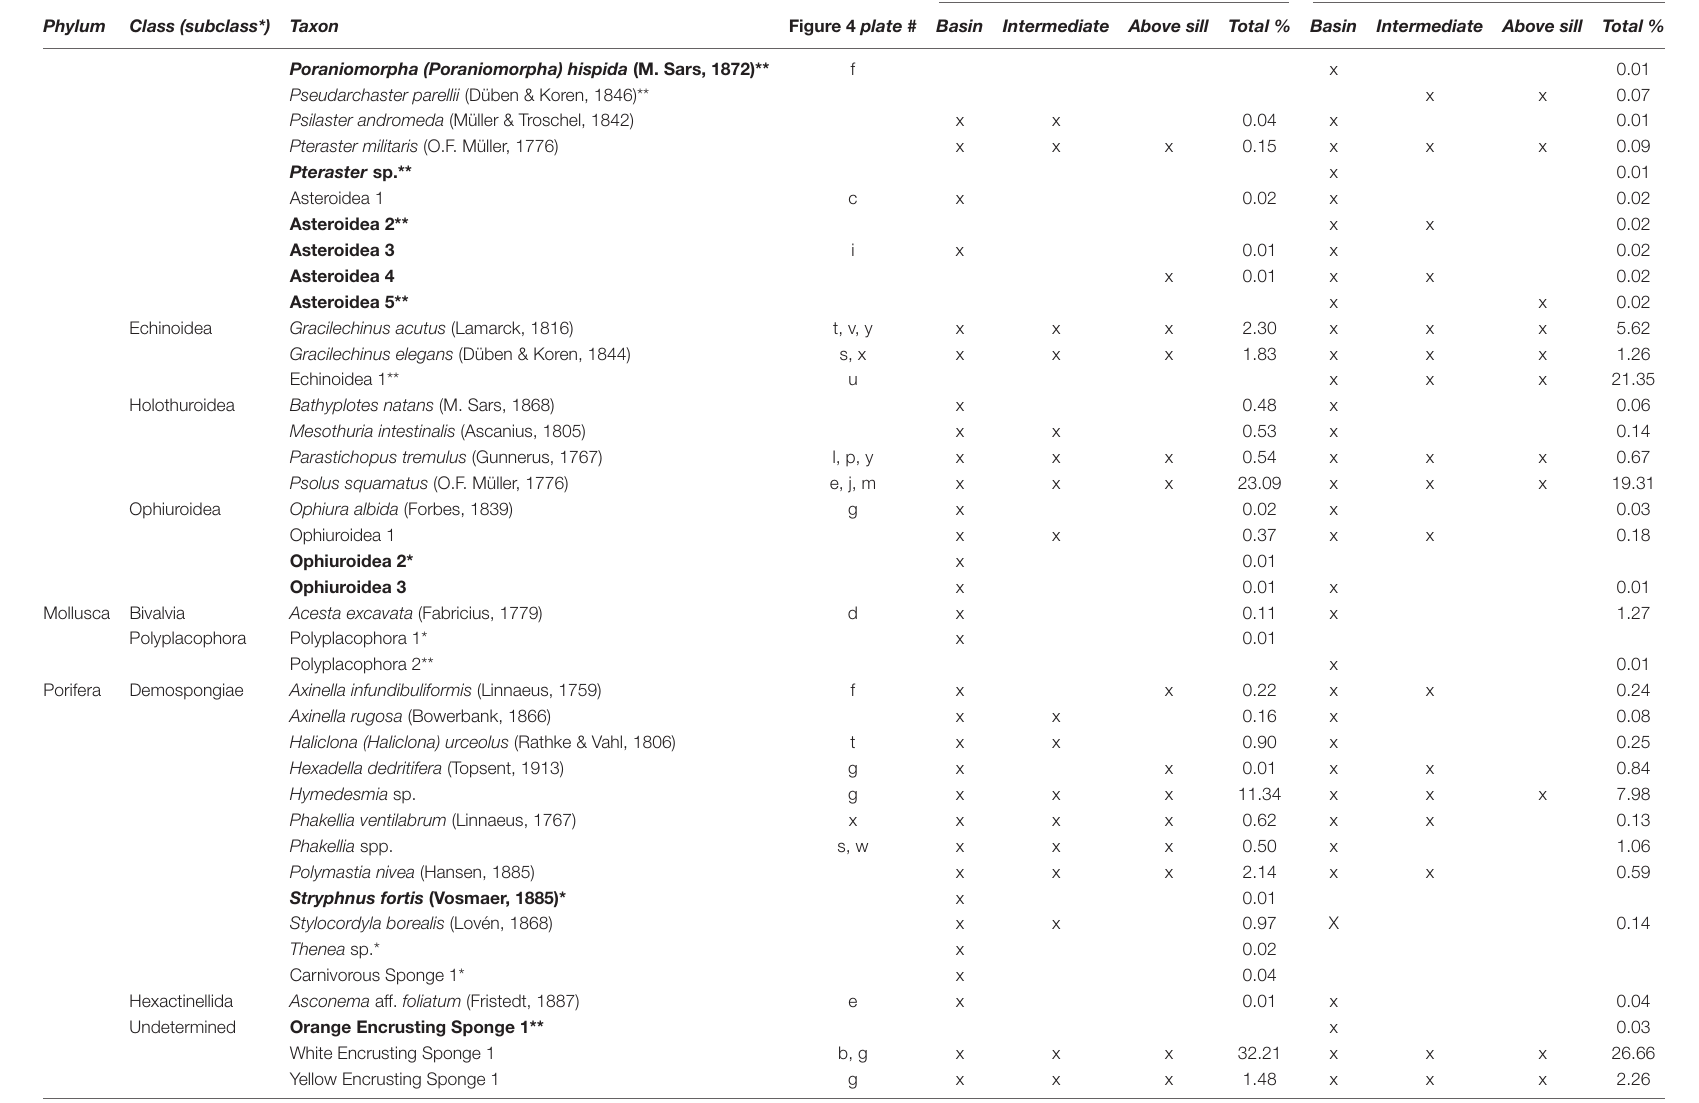
Figure 4 plate # Basin Intermediate Above sill Total % Basin Intermediate Above sill Total